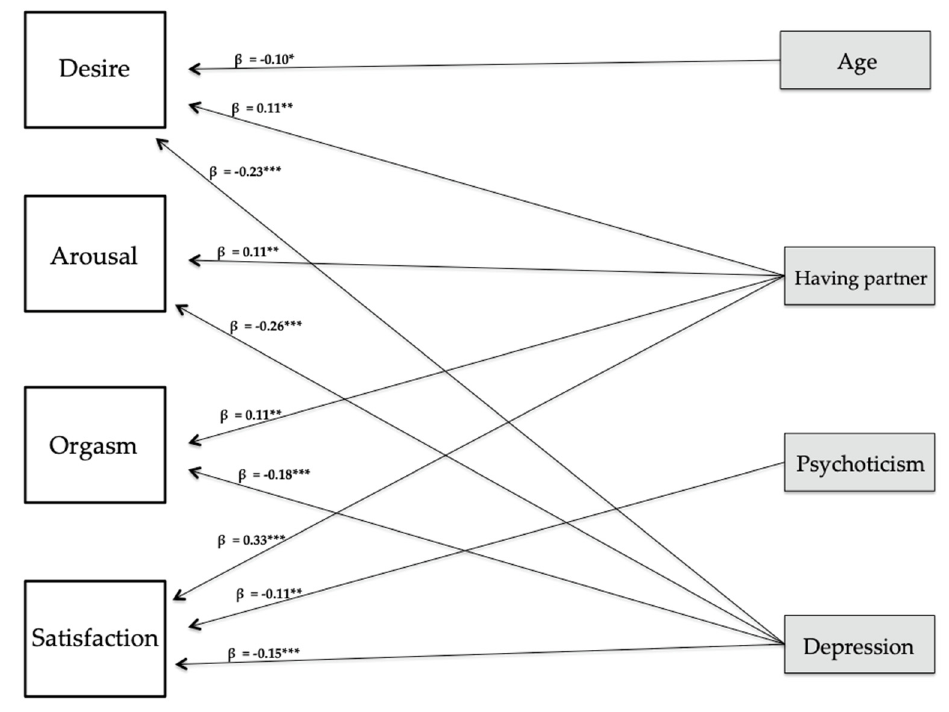
Figure 2. Graphical representation of the SEM in women. *** p < 0.001; ** p < 0.01; * p < 0.05.